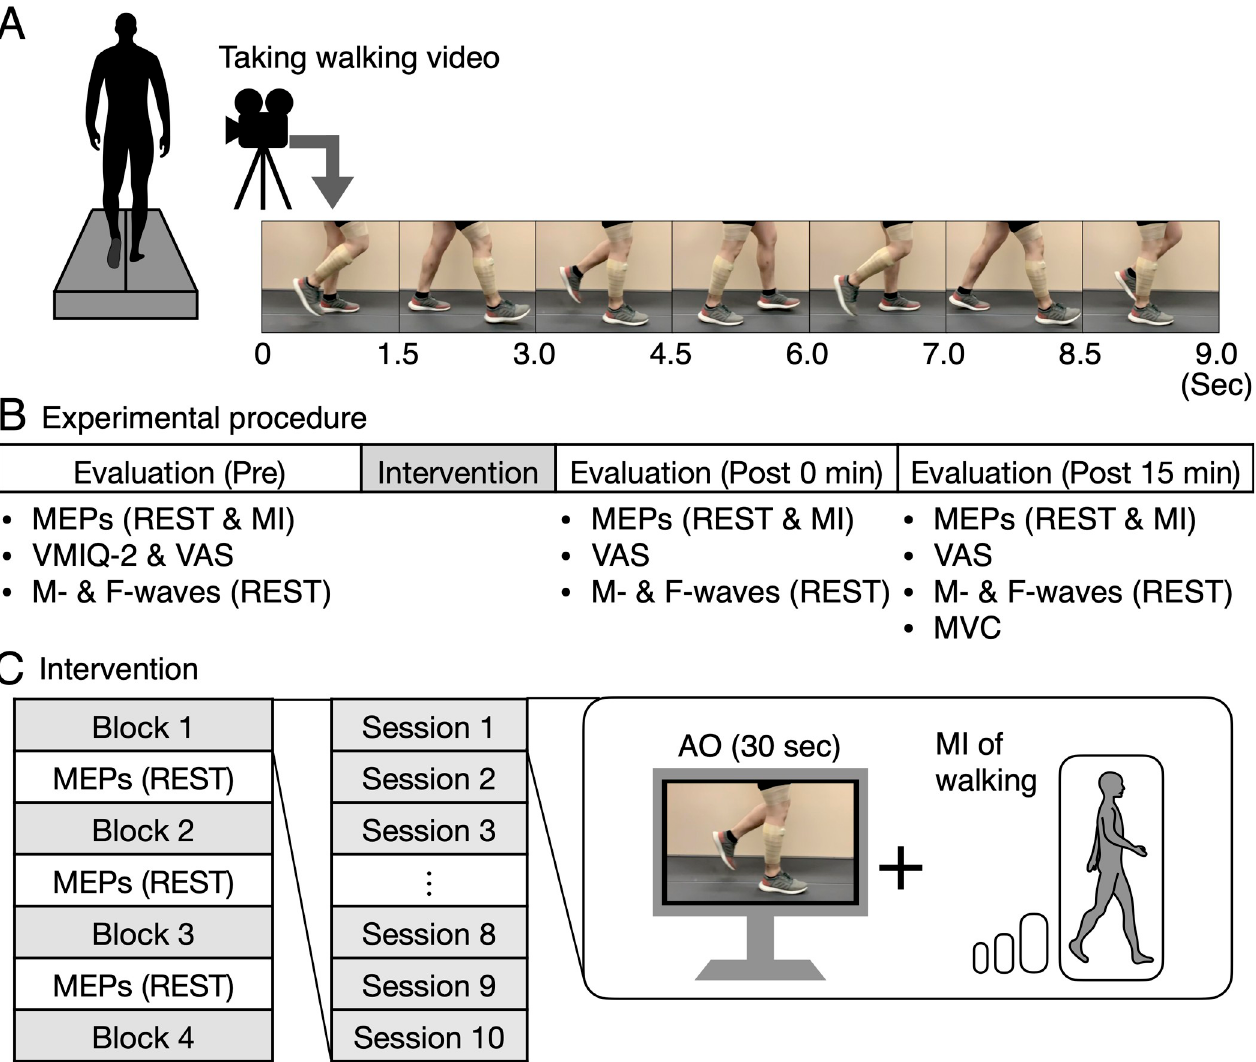
Fig 1. Preparation for the intervention, study design, and experimental procedure. A video of a healthy man walking is captured for action observation (AO), and examples of 9 s of the walking video are displayed (A). The experiment consists of evaluations and interventions (B). Before and after the intervention, motor evoked potentials (MEPs), F-waves, and M-waves are recorded when the participants relaxed (REST). In addition, MEPs are recorded when the participants performed motor imagery (MI) of walking. The intervention consists of four blocks and three evaluation sessions, with each block consisting of 10, 30-s sessions (C). For each block, a walking video is provided for 30 s, and the participants are asked to observe the video and imagine walking (i.e., AO+MI). For each session, MEPs are recorded when the participants relaxed (REST). At the end of the experiment, maximal voluntary contraction (MVC) is recorded for each recorded